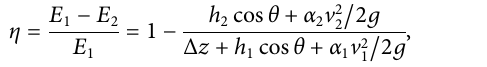
Figure 9 . Generally, the value of “ Pa_Tra/Pa_Squ ” is greater than